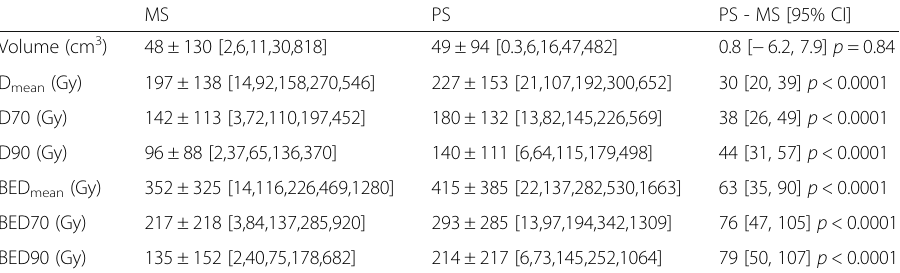
Table 3 Summary of volume and AD/BED metrics for morphologic and PET-based segmentation